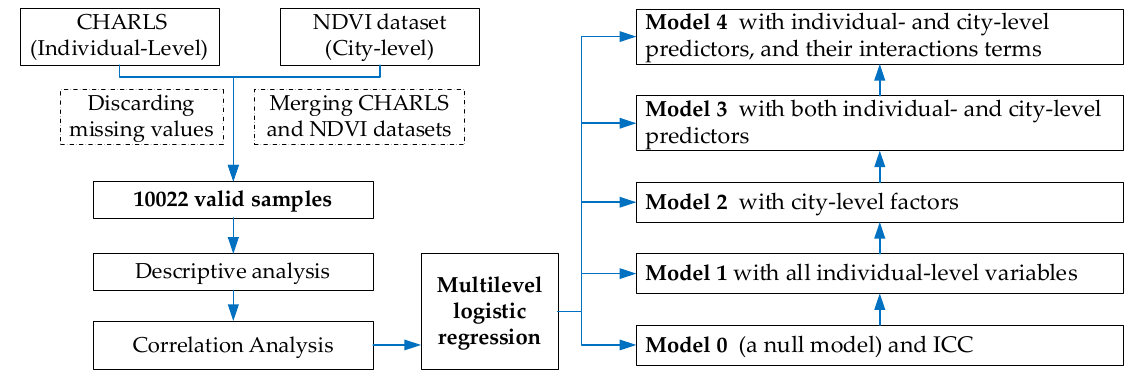
Figure 3. Flowchart of the study.